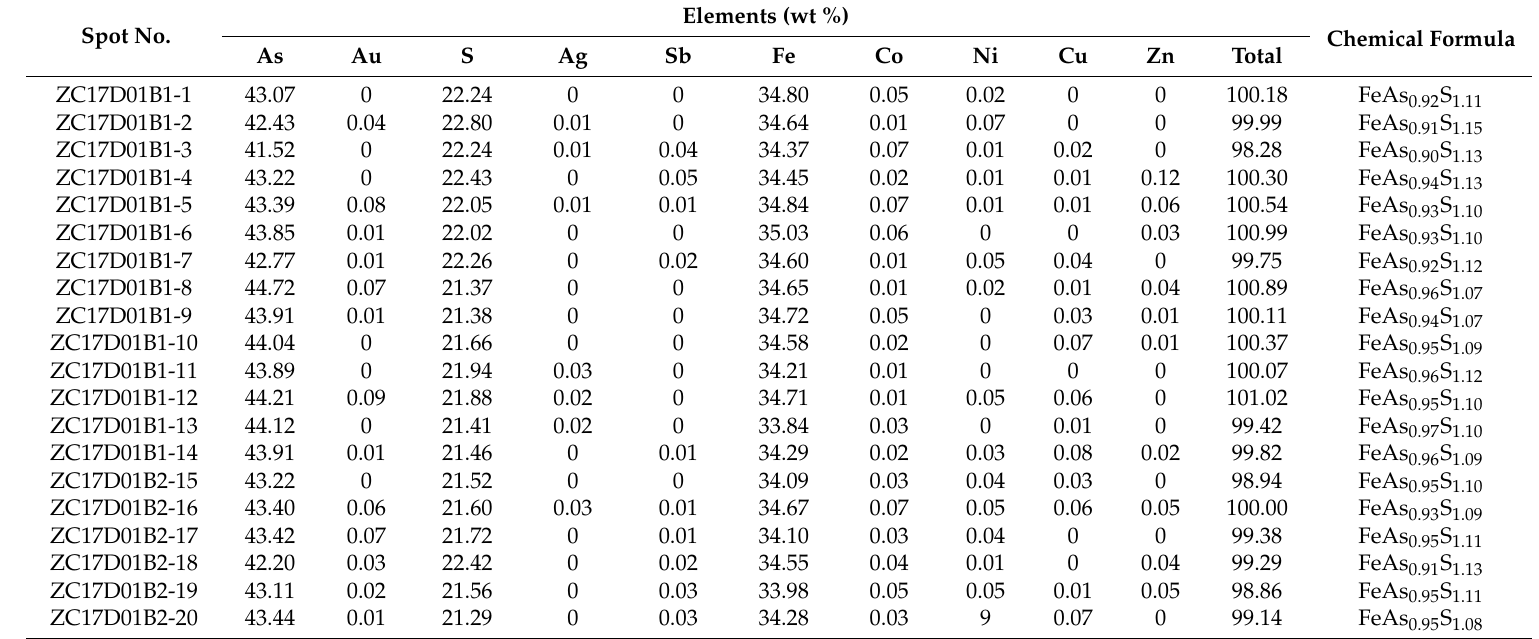
Table 1. Chemical compositions of arsenopyrite at the Zhengchong gold